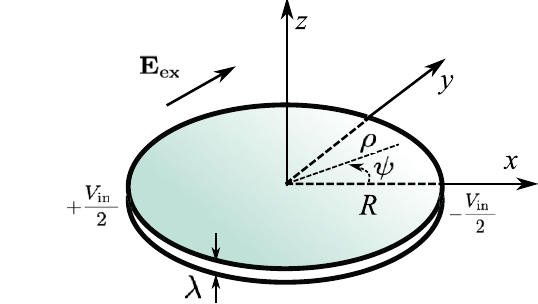
Figure 1. Left: schematic view of a liquid-film motor. A suspended liquid film is under the action of two electrical forcing. The first field is due to a voltage difference V in that is applied to the conducting electrodes forming two lateral edges of the frame. The second force comes from an externally applied electric field E ex , asymptotically parallel to the plane of the film. As a result of these applied fields, the liquid fluid will eventually flow rotationally. Right: An idealized symmetric geometry where the frame is replaced by a circular frame with V in cos ψ is applied to the radius R . In this case a potential distribution V in (ψ) = − 2